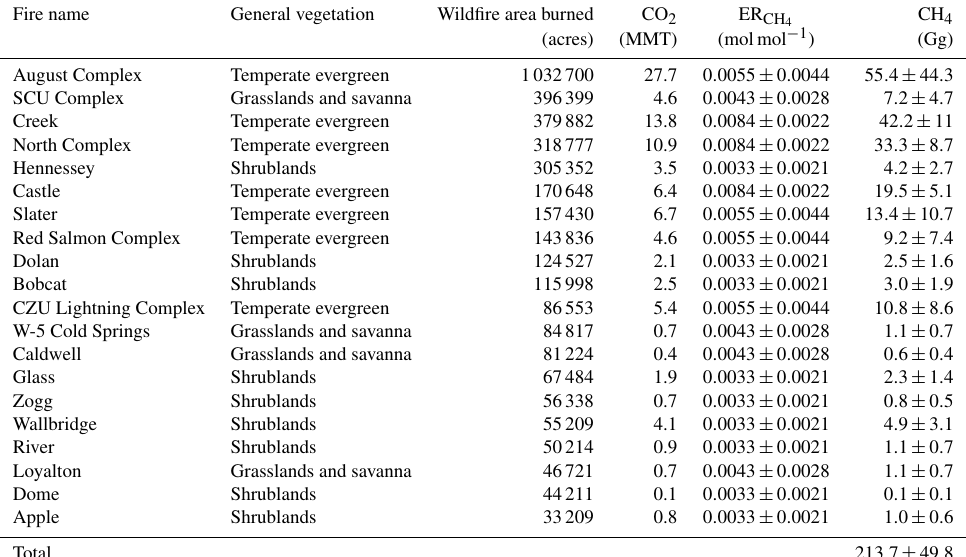
Table E1. Emissions of the 20 largest wildfires of 2020 in California. Estimates of CO 2 were obtained from CARB (2020). Emission ratios for Sierra Nevada fires (Creek, Castle, and North Complex) were derived from EF CH Santa Cruz, and San Francisco counties. SCU is for the Santa Clara Unit. The rest of the ER CH on values from Prichard et al. (2020) and Xu et al.